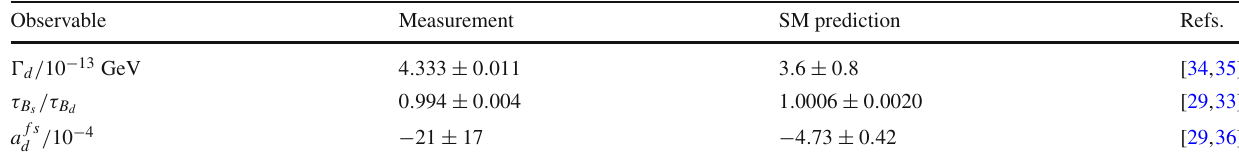
Table 3 Measurements and predictions for further observables that constrain BSM physics in b → c ¯ u ( d , s